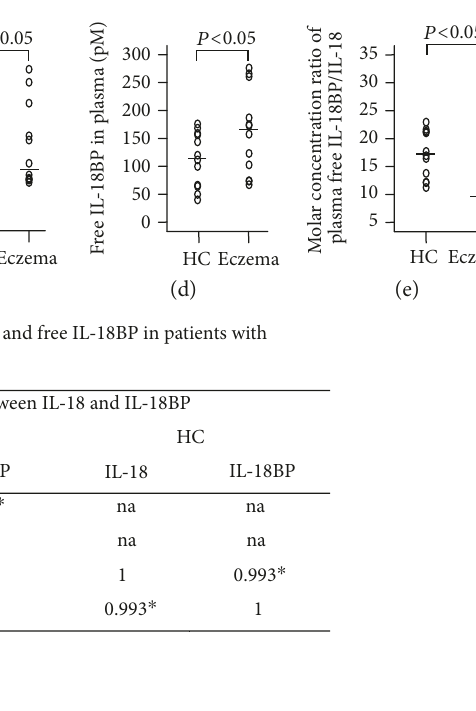
Figure 1: Scatter plots of levels of IL-18 and IL-18BP in plasma of patients with eczema and healthy control (HC) subjects. Levels of total IL-18 (a), total IL-18BP (b), free IL-18 (c), and free IL-18BP (d) and the molar concentration ratios of plasma IL-18BP/IL-18 (e) were shown. Each symbol represents the value from 1 subject. The median value is indicated with a horizontal line. P < 0 05 was taken as statistically signi fi cant. (f) The spearman ’ s rho/correlation coe ffi cient between the plasma level of free IL-18 and free IL-18BP. ∗ P < 0 05